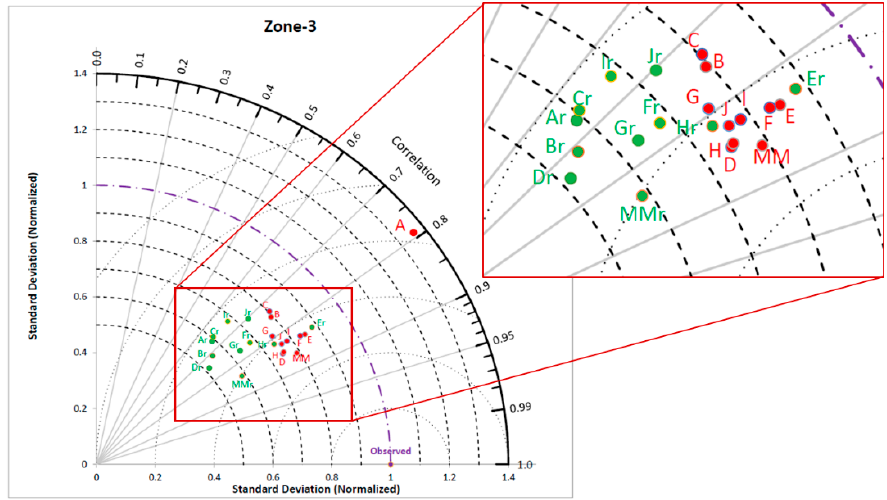
Figure 10. Taylor diagram for downscaling with Re-Obs and GCM-Obs models for zone 3. Notations are same as the ones used in Figure 8.